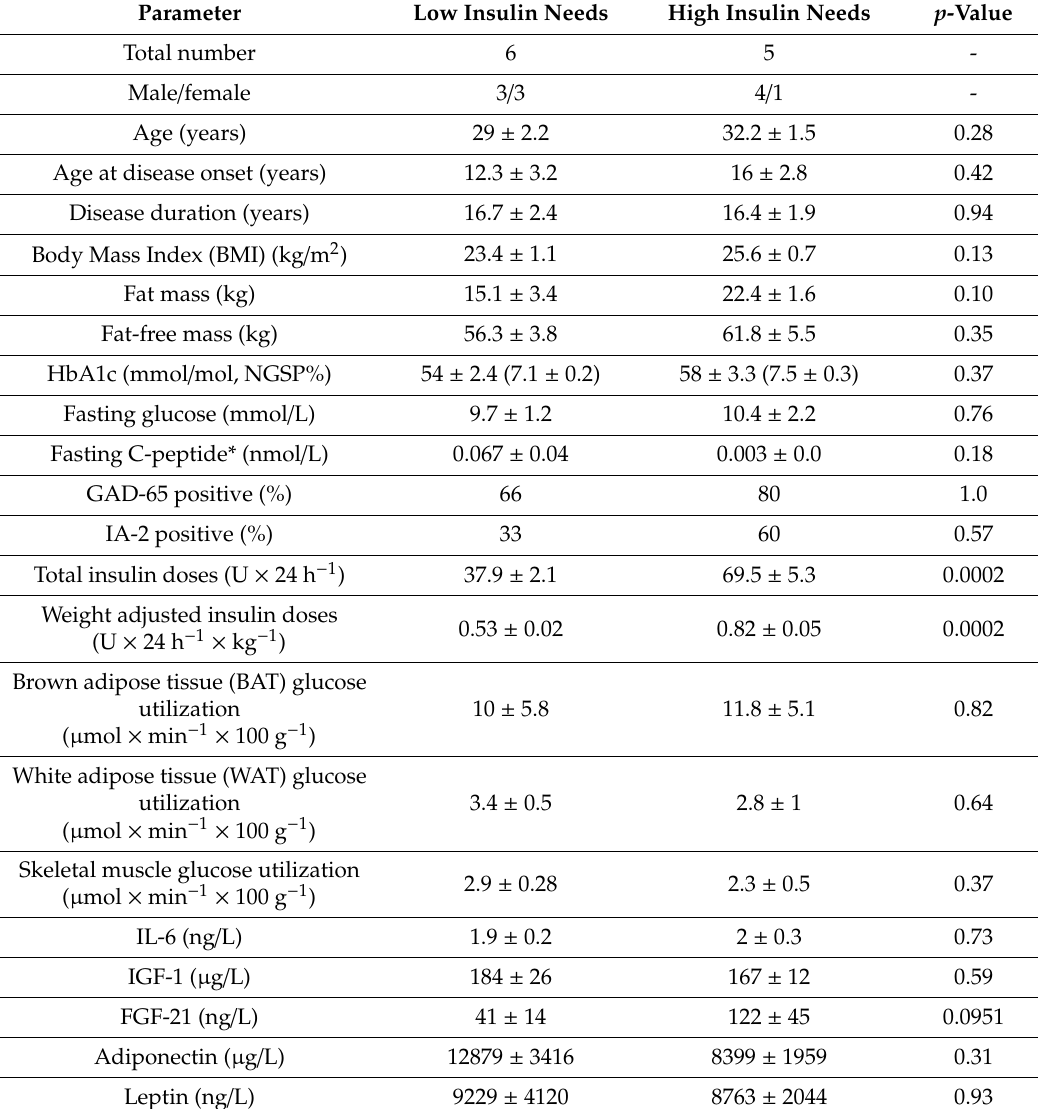
Table 1. Descriptive data of individuals with type 1 diabetes with either low or high insulin needs. Parameter Low Insulin